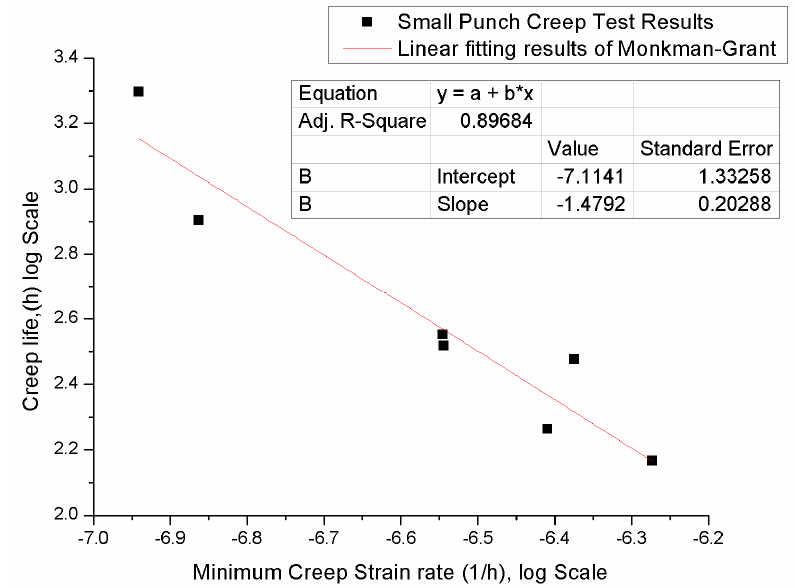
Figure 9. The small punch creep fitting results of the Monkman-Grant relation of 16Mo3.